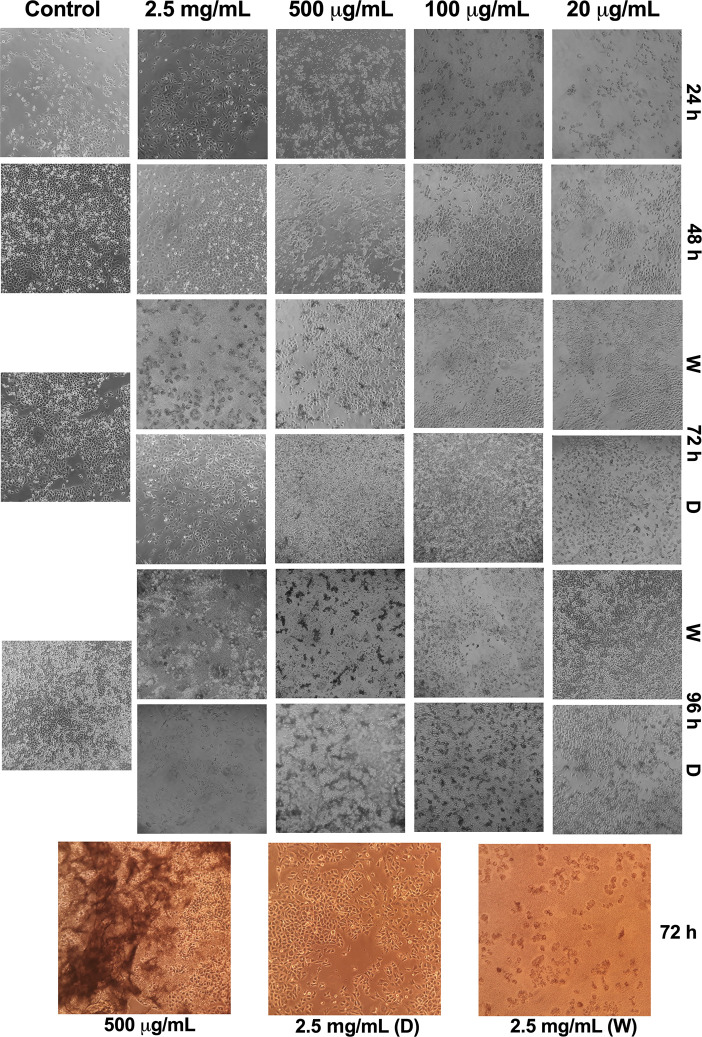
Representative images of morphological appearance of A375 cells exposed to polyvinyl alcohol carbazate (PVAC) at different concentrations. Rows represent time points (h) and columns represent concentrations of PVAC. Concentrations lower than 20 µg/ml had a similar morphological appearance as the control, and were therefore excluded. Black and white images are the same passage as the representative example for flow cytometry. Bottom three pictures in color are from different cell passage. D, dose; W, wash.